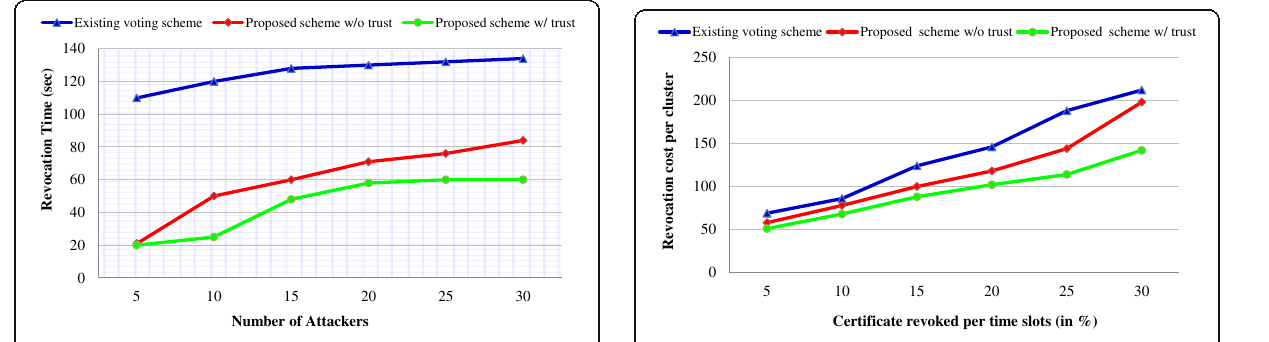
Figure 19: packet delivery ratio with node velocity, and Fig. 20: packet delivery ratio with misbehaving nodes, represent the efficiency of the proposed scheme in packet delivery ratio (PDR) while participating a secure group communication. Figure 19 shows the impact of node mobility in 25 nodes MANET. It is observed that, as the node velocity increases, the PDR drops